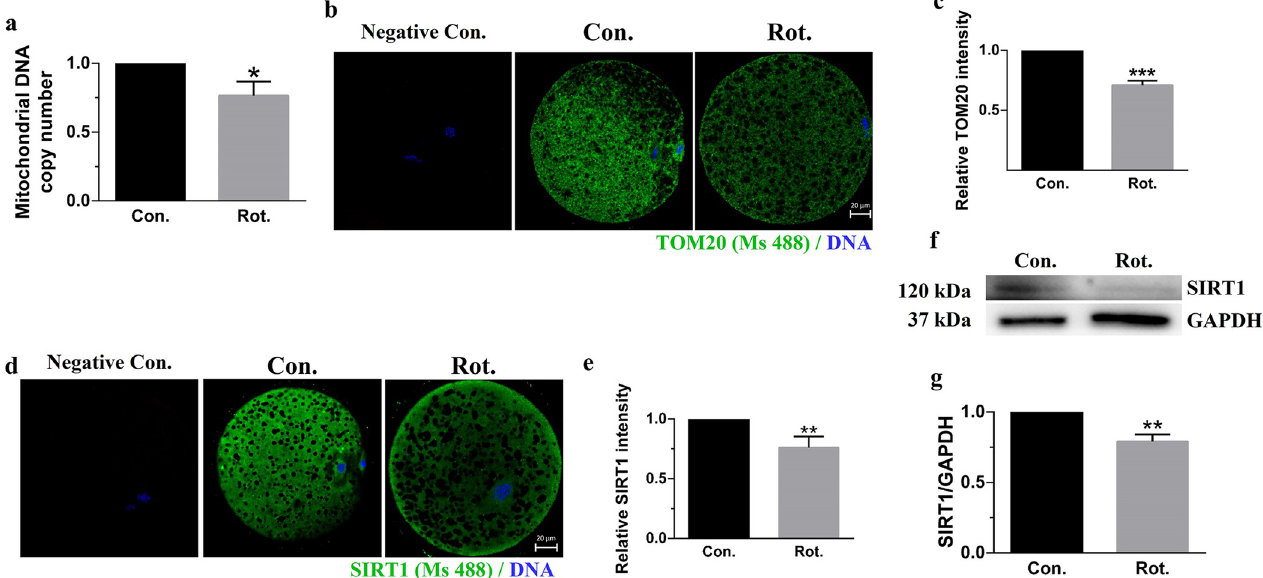
Fig 4. Rotenone disrupts mitochondrial biogenesis in porcine oocytes. (A) Relative mitochondrial DNA copy number of oocytes in the control and rotenone-treated groups (n = 3). (B) Representative images of TOM20 intensity in the control and rotenone-treated groups. Green = TOM20, blue = DNA. Scale bar represents 20 μ m. (C) Relative fluorescence intensity of TOM20 in the control and rotenone-treated groups (n = 20) (D) Representative images of SIRT1 intensity in the control and rotenone-treated groups. Green = SIRT1, blue = DNA. Scale bar represents 20 μ m. (E) Relative fluorescence intensity of SIRT1 in the control and rotenone-treated groups (n = 30). (F) Western blot of SIRT1 (120 kDa) protein expression in porcine oocytes after rotenone treatment. (G) Relative intensity analysis for SIRT1 (n = 3). Con., control group. Rot., 3 μ M rotenone-exposed group. Negative Con., only the secondary antibody was stained in mature oocytes as a negative control. � (P < 0.05), �� (P < 0.01), ��� (P < 0.001).